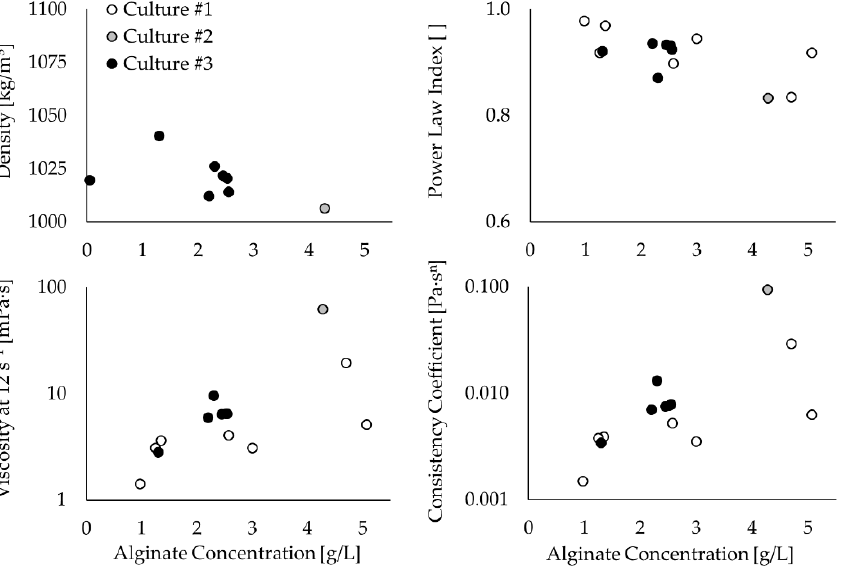
Figure 4. Evolution of the rheological parameters and density for the microbial alginate batch production. Data in white, grey and black circles for culture #1, #2 and #3, respectively.